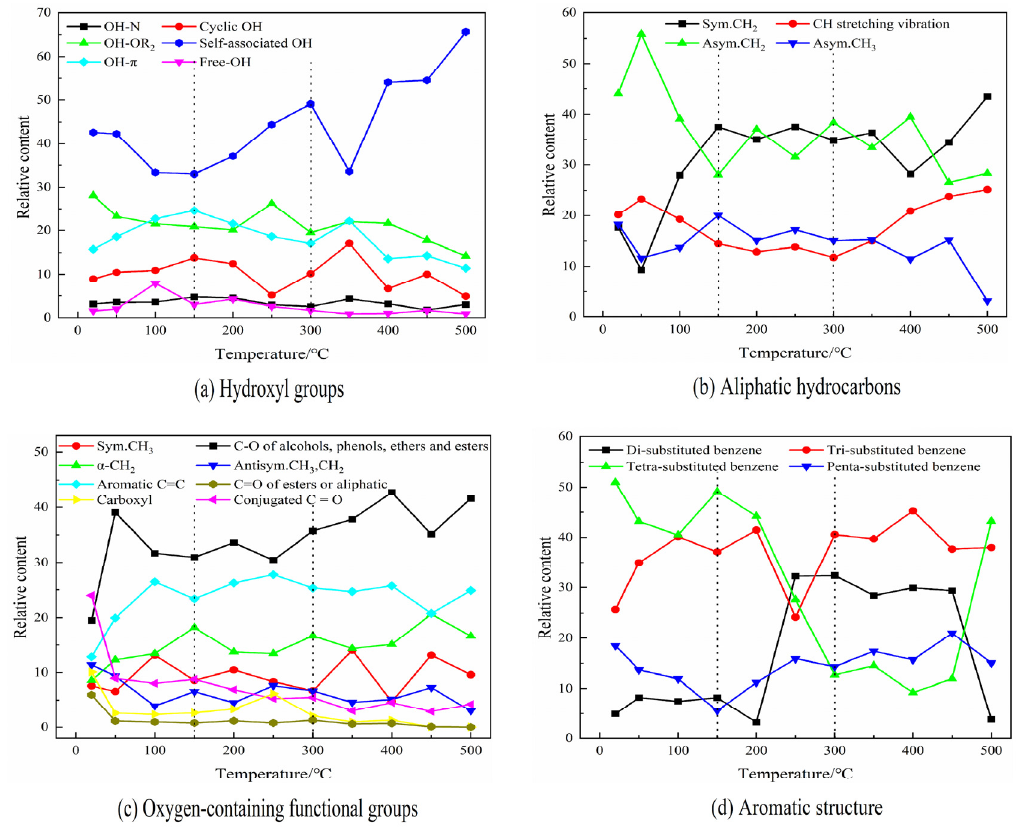
Figure 12. Changes of different functional groups at different temperatures ( a : Hydroxyl groups, b : Aliphatic hydrocarbons, c : Oxygen-containing functional groups, d : Aromatic structure).